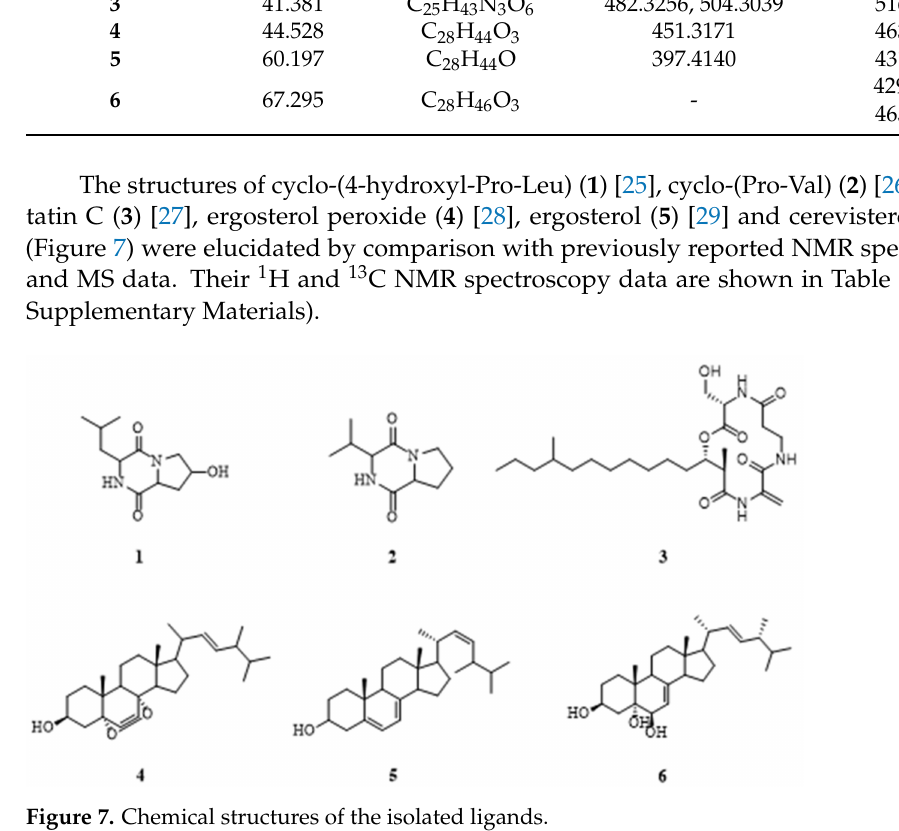
Figure 7. Chemical structures of the isolated